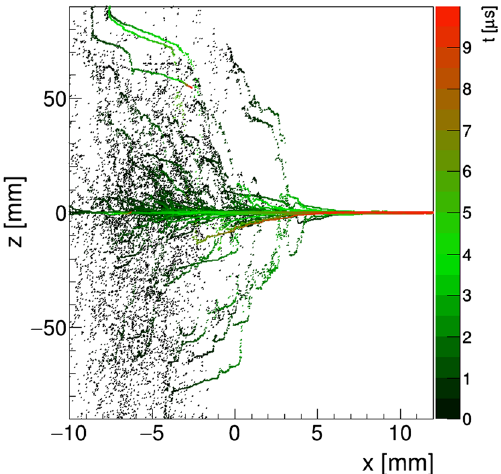
Fig. 10 Muon positions in the xz -plane for various times. The time is given by the color scale. Muon beam centered at x = − 6 mm with 3 mm radius is stopped uniformly along the z -axis. The muons drift in the + x -direction while compression occurs in z -direction